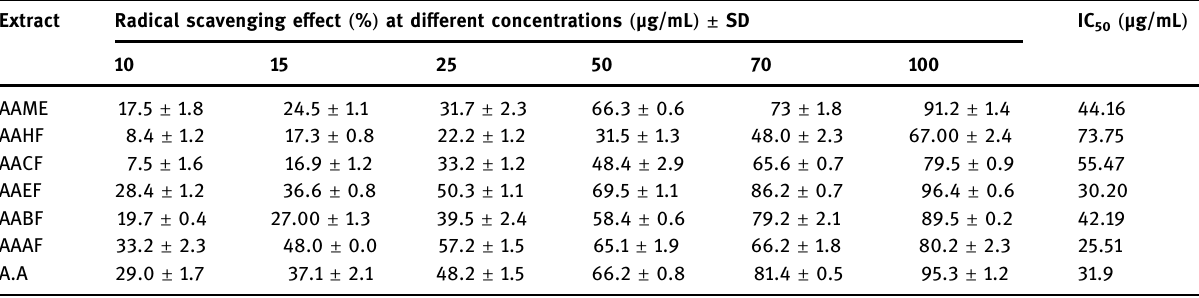
Table 3: Percent ( % ) DPPH radical - scavenging activity of A. alpinum extract and standard AA with IC 50 values Extract